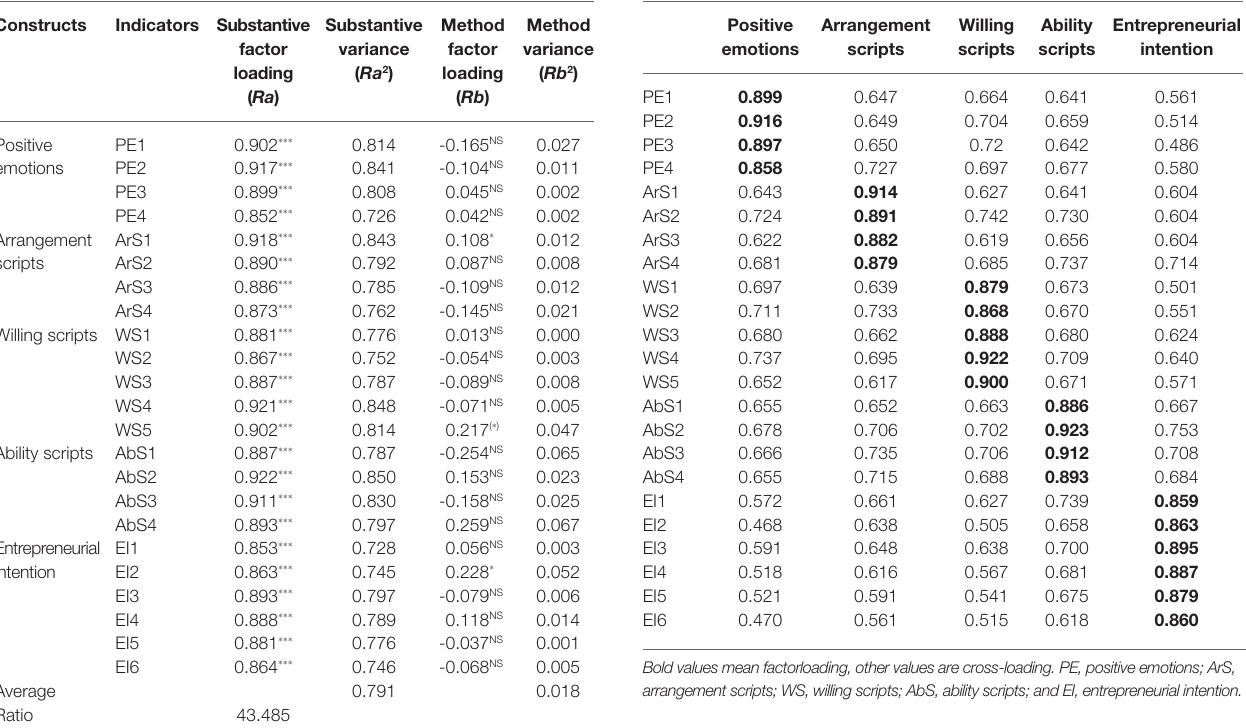
TABLE 3 | An alternative test for common method bias.